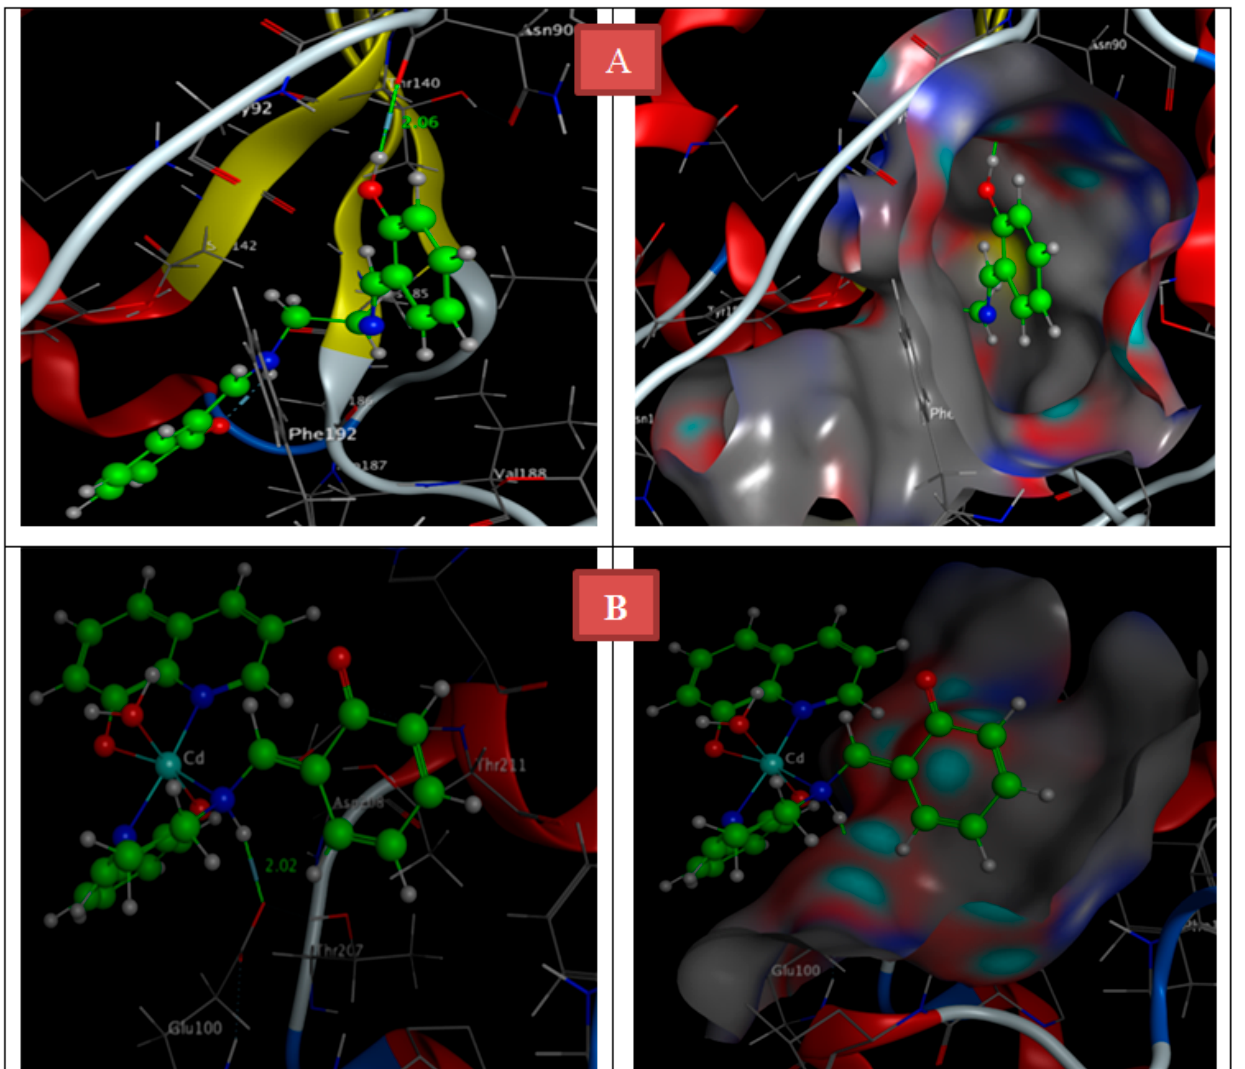
Figure 13. Molecular docking simulation studies of the interaction between the ligand ( A ) and Cd(II) metal complex ( B ), with the active site of the receptor of breast cancer oxidoreductase (PDB ID: 3HB5). The docked conformation of the compound is shown in ball and stick representation.